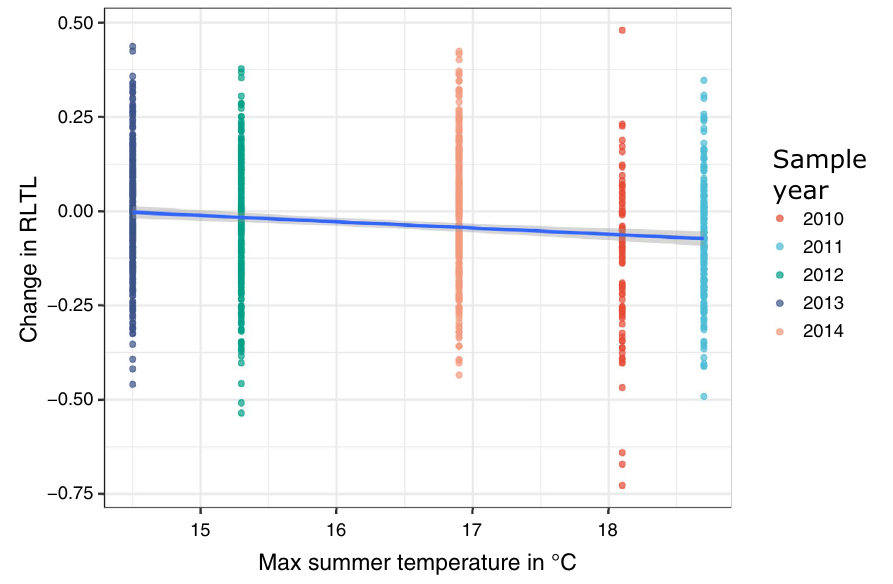
Figure 2. Association between maximum summer temperature and RLTL